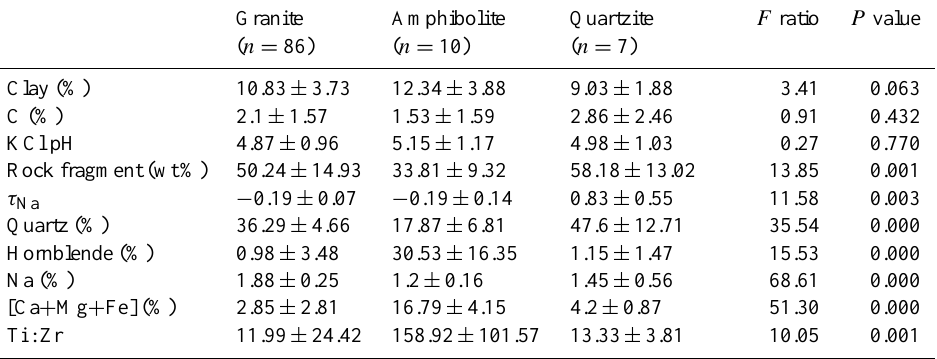
Table 2. Unequal variance t tests – all horizons with parent material as the main effect.